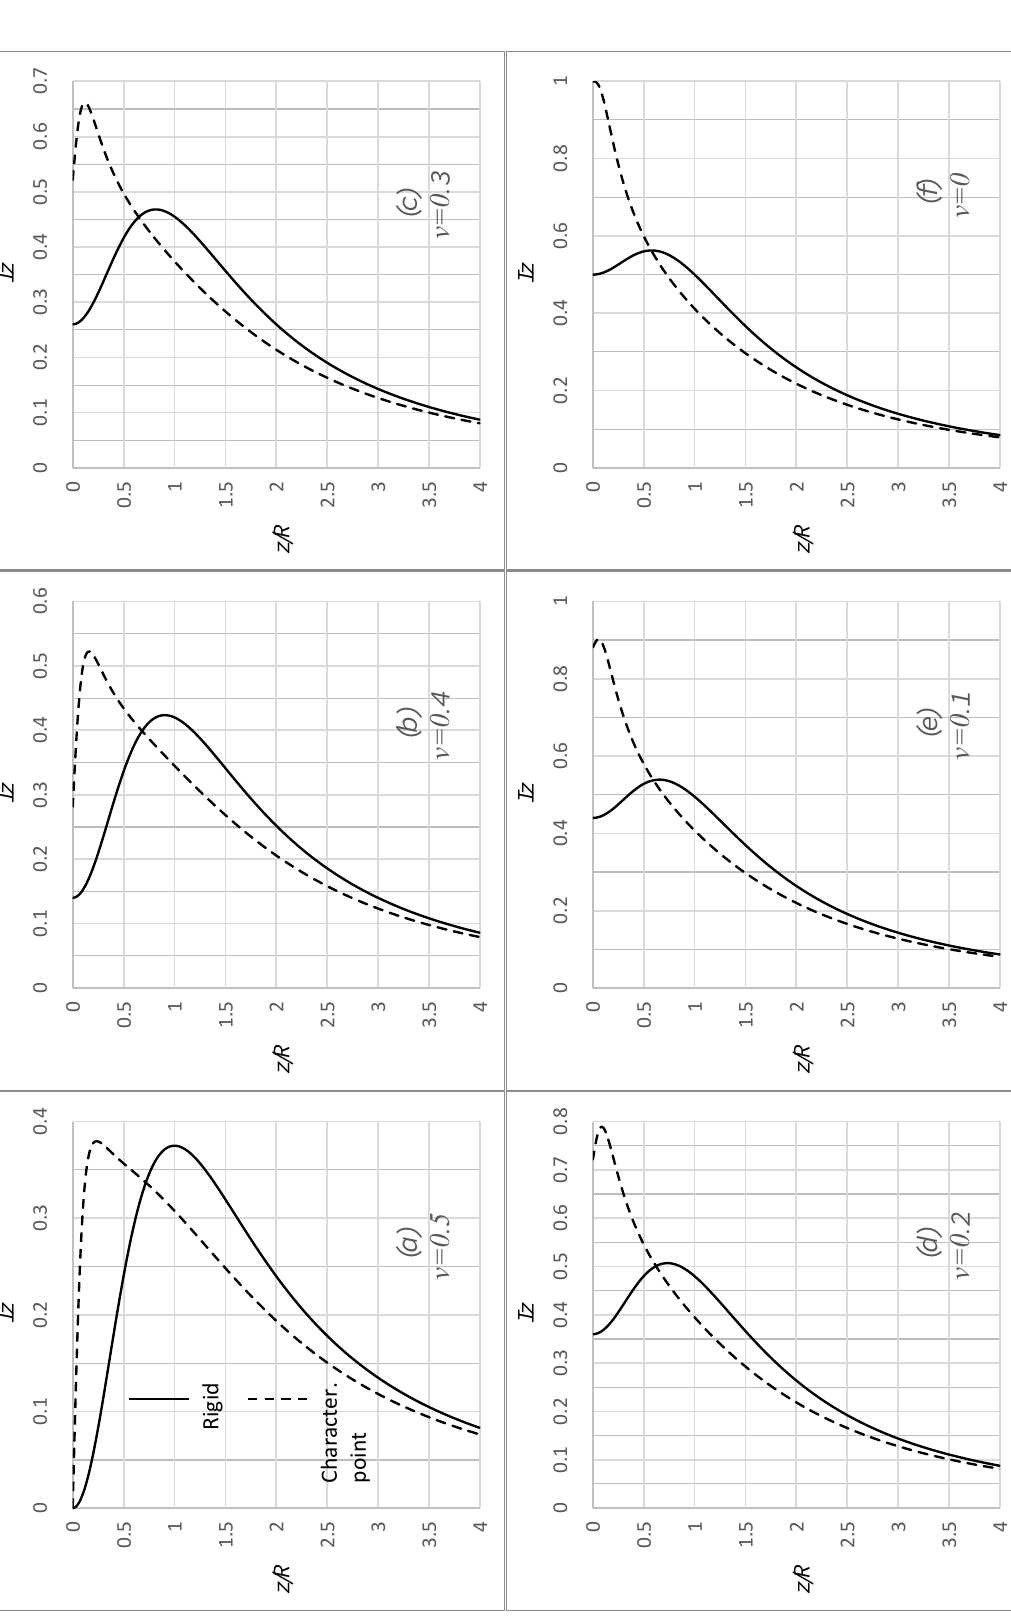
Figure 11. I z versus normalized depth charts for various ν values of soil (( a )–( f ) for ν = 0 to 0.5 with 0.1 interval), comparing the case of rigid circular footing with the respective flexible footing at the characteristic point.